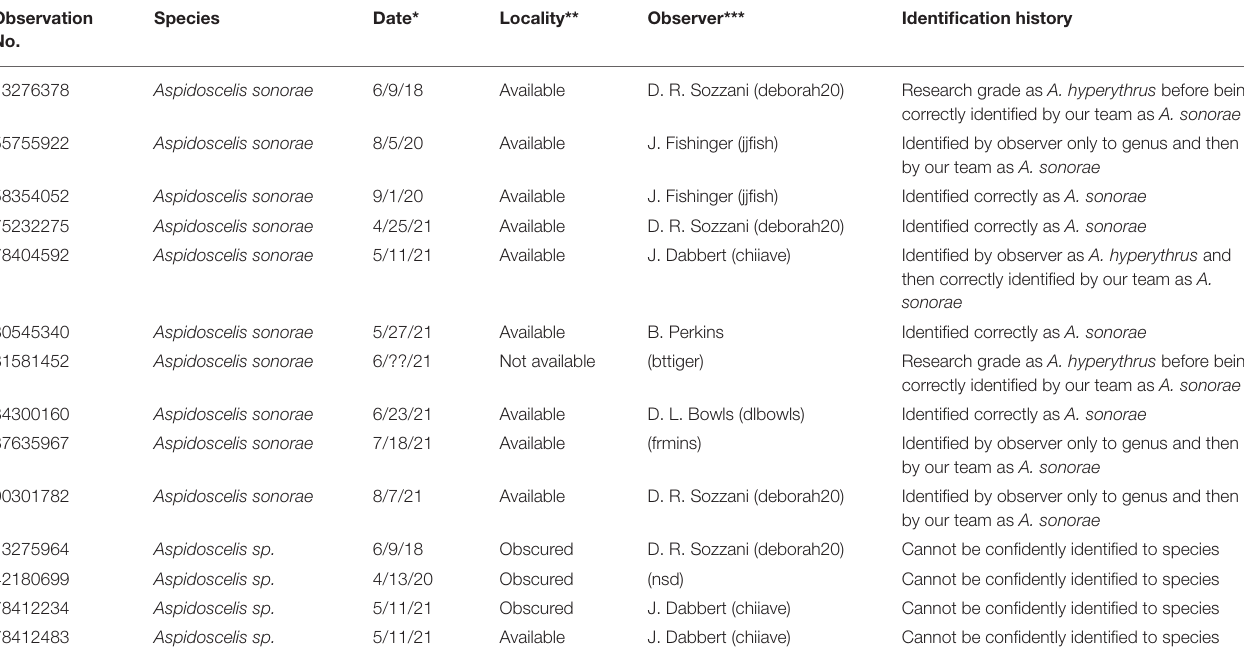
TABLE 1 | iNaturalist observations that are confirmed or possible invasive Aspidoscelis sonorae in northwestern San Diego County. Observation